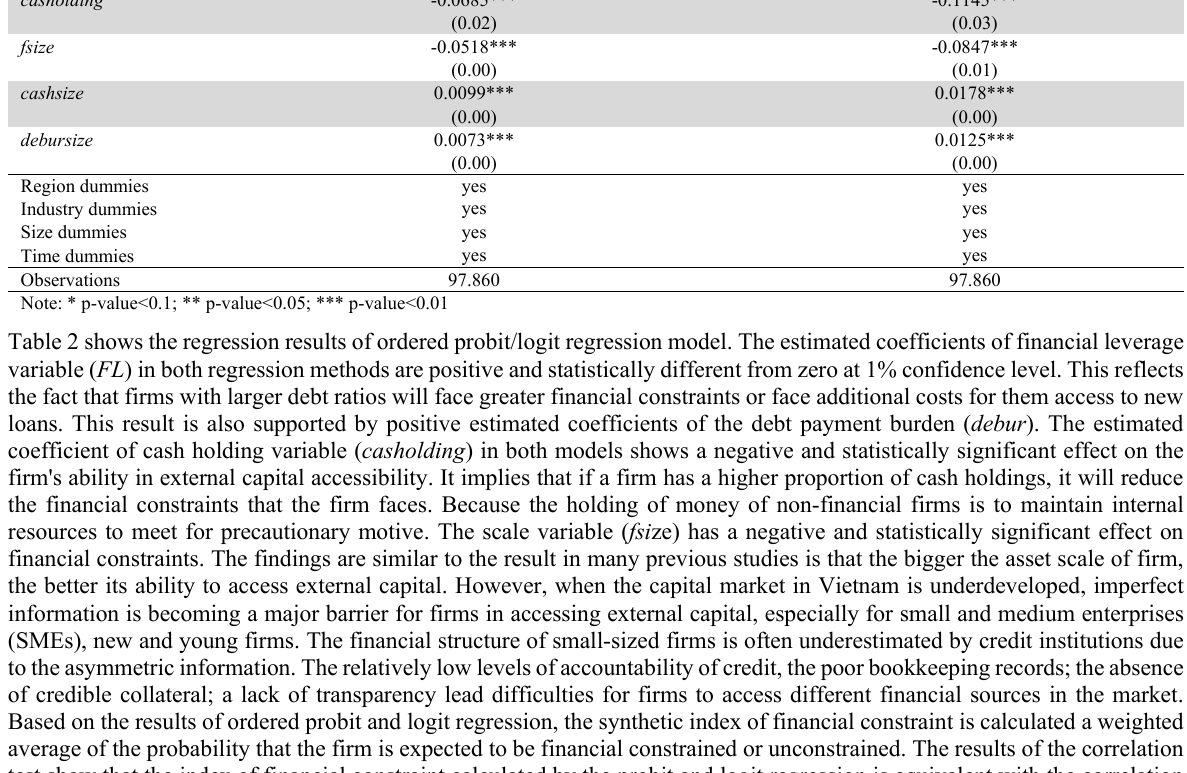
Ordered Probit Model (OPM) Ordered Logit Model ( OLM)